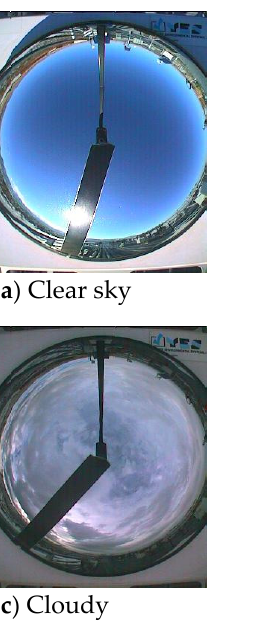
Figure 1. The total sky images under four different weather conditions.